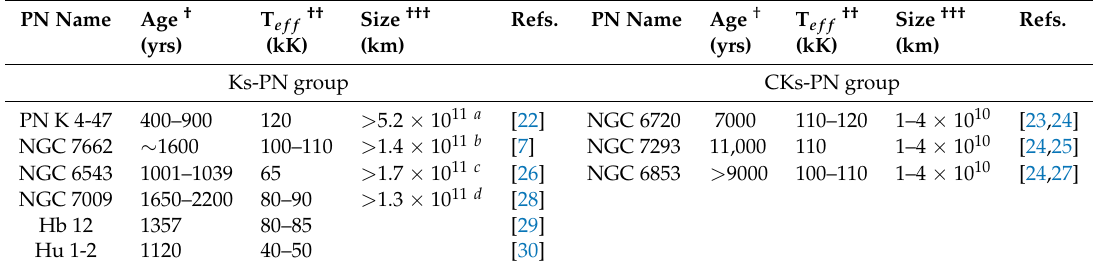
Table 1. Nebular ages, LISs size, and effective temperatures of central